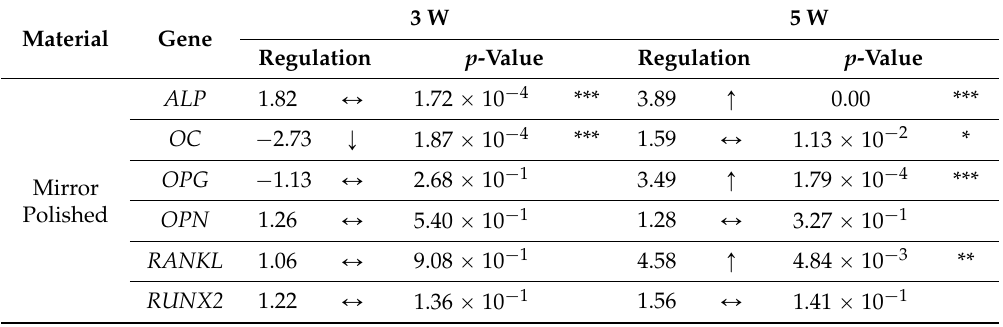
Table 6. The influence of POPE on Saos-2 gene expression was determined via real-time PCR analyses by normalizing each POPE-coated material to the corresponding material without phospholipids ( ∆∆ C t ) after three weeks (3 W) and five weeks (5 W). Regulation: fold expression values are compared to regulation threshold ( Ò up regulation, Ó down regulation, and Ø no change). p -values given are absolute values and significance levels where * ď 0.05, ** ď 0.01, and *** ď